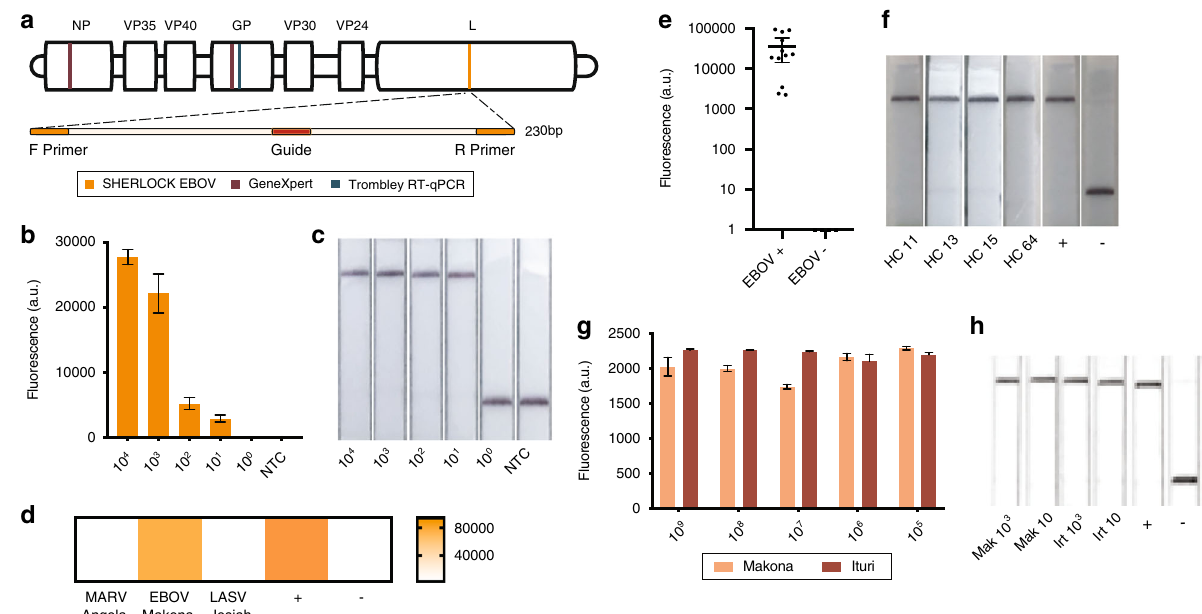
Fig. 1 Detection of EBOV. a Schematic of the SHERLOCK EBOV assay. b , c Detection of a serial dilution of EBOV synthetic DNA using ( b ) mean fl uorescence of three technical replicates and ( c ) lateral fl ow readouts. Error bars indicate ±1 SD for three technical replicates. d Test of cross-reactivity using MARV, EBOV, and LASV viral seedstock cDNA. Heat map is measured in Fluorescence (a.u.). e SHERLOCK testing of cDNA extracted from 12 con fi rmed EBOV-positive and 4 con fi rmed EBOV-negative samples collected from suspected EVD patients during the 2014 outbreak in Sierra Leone. Error bars indicate 95% con fi dence interval. f Four of the samples from e were also tested by collaborators using lateral fl ow detection. g , h Detection of serial dilution of synthetic RNA from Ituri, DRC and Makona, Sierra Leone using ( g ) fl uorescence where error bars indicate ±1 SD for three technical replicates and ( h ) lateral fl ow readouts carried out at USAMRIID. Source data are in the Source Data fi